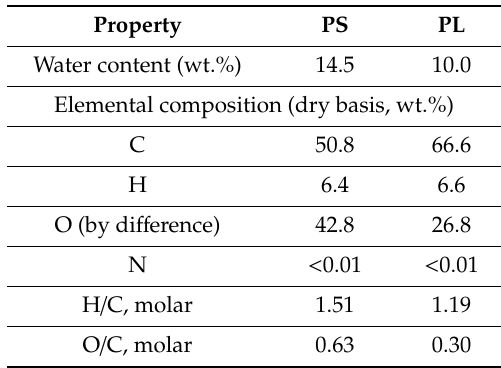
Table 3. Elemental composition of the PS and PL used in this study.